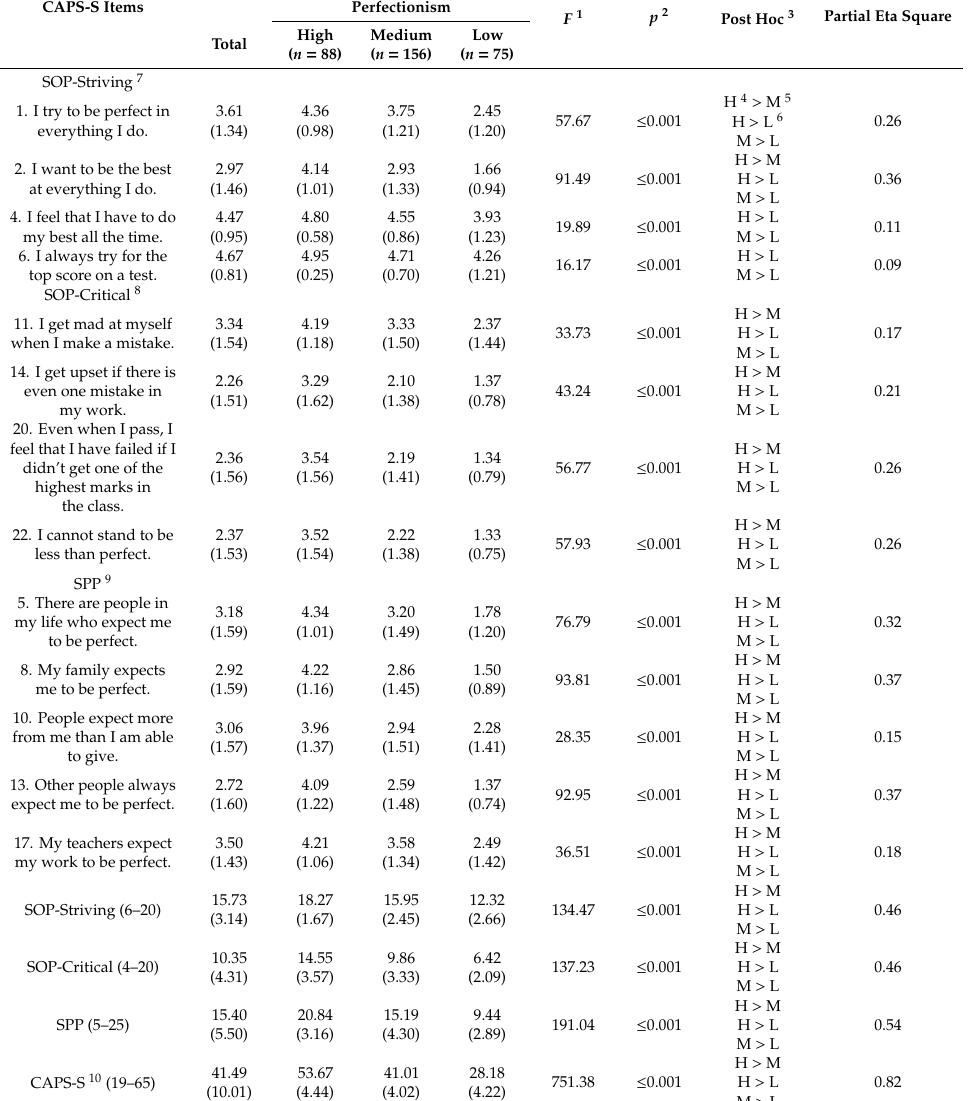
Table 2. Mean (standard deviation) for CAPS-S items and di ff erences in scores among the three groups: high, medium, and low